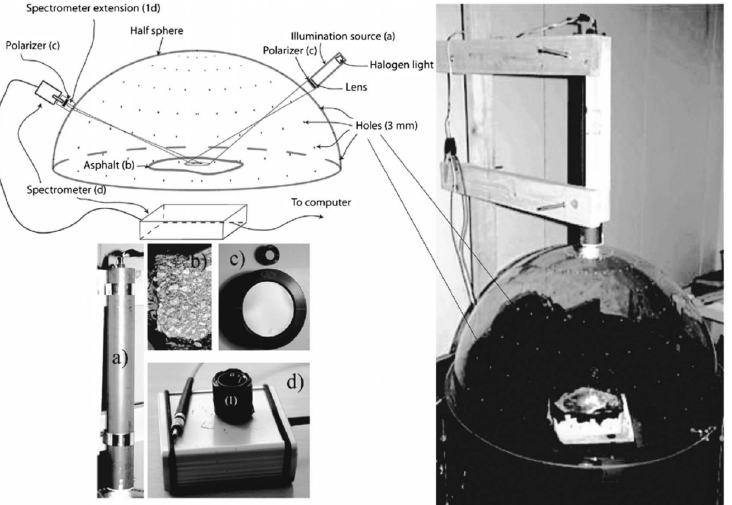
Figure 14. Diagram of the experimental setup of Casselgren. Left top is a sketch over the measuring procedure. Right is the experimental setup. A hemispherical Plexiglass hood was used. Holes were punched at 10-degree intervals in the longitude and latitude directions of the hood with a diameter of 3 mm, and the hood was placed over the road asphalt sample ( left bottom ( b )). A polariser ( left bottom ( c )) was placed in front of the light source ( left bottom ( a )). The spectrometer with the extension ( left bottom ( d )), and the direction of polarisation was adjusted both horizontally and vertically